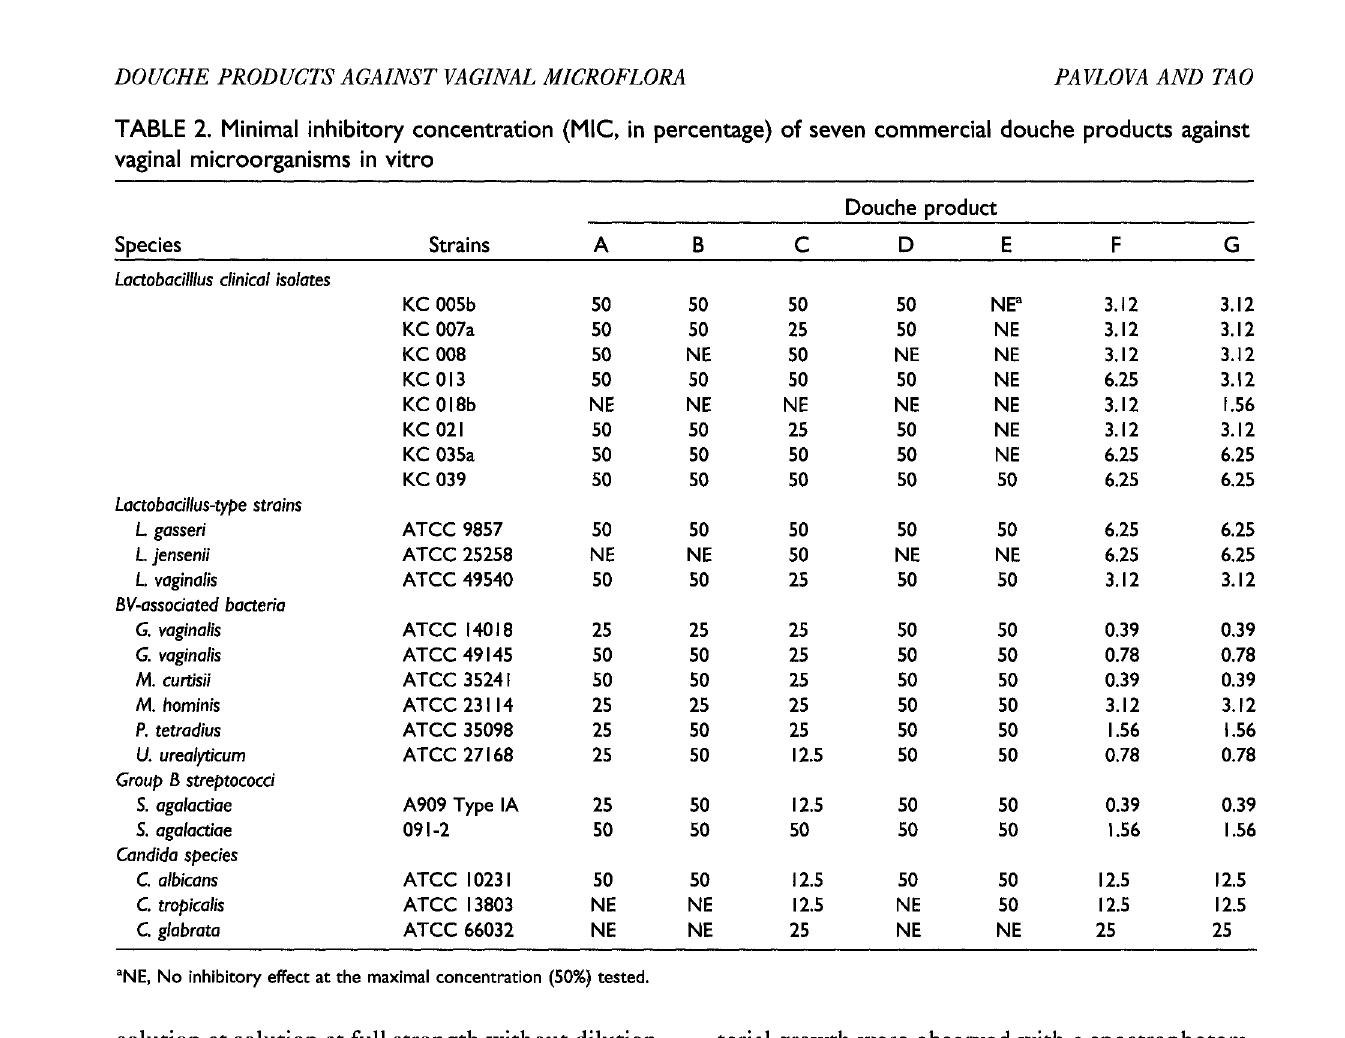
TABLE 2. Minimal inhibitory concentration (MIC, in percentage) of seven commercial douche products against vaginal microorganisms in vitro Species